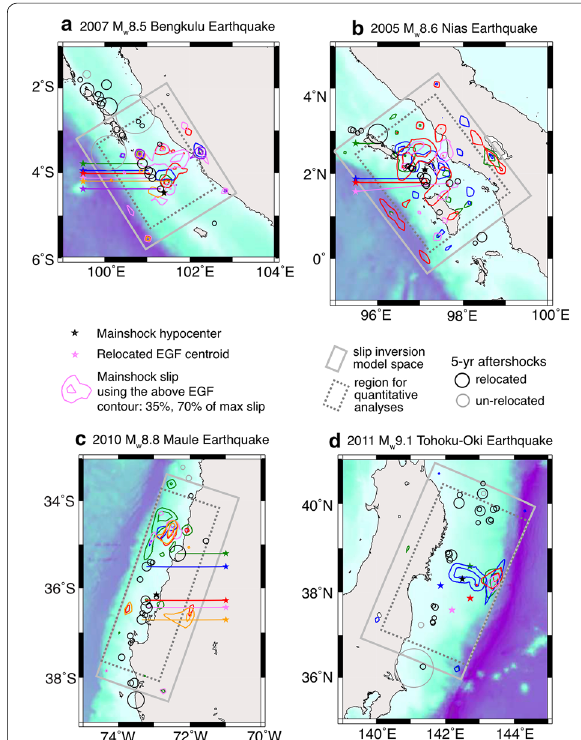
Fig. 8 Accumulated slip using all of the EGFs and interplate aftershocks in the 5 years following the a Bengkulu, b Nias, c Maule, and d Tohoku‑Oki earthquakes. The total slip of each mainshock (contours represent 35% and 70% of the maximum slip) using all of the EGFs (same color as corresponding contours of slip, locations indicated by stars) are shown for each study region. Circles represent the interplate aftershocks that occurred in the 5 years following each mainshock (relocated in black and un‑relocated in gray), and are sized by their 2 R values (Eq. 1). Gray rectangles denote the assigned fault planes for the slip inversion analysis, and dotted dark gray rectangles indicate the regions where slip was considered in the quantitative